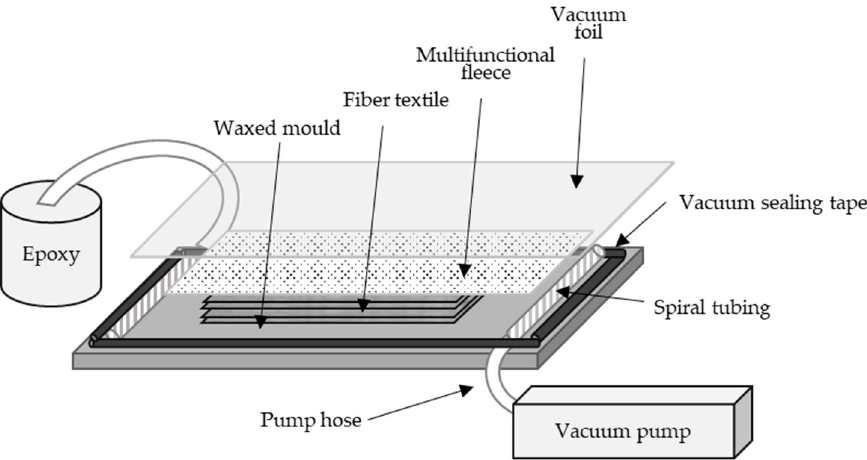
Figure 4. Schematic representation of the vacuum infusion process.